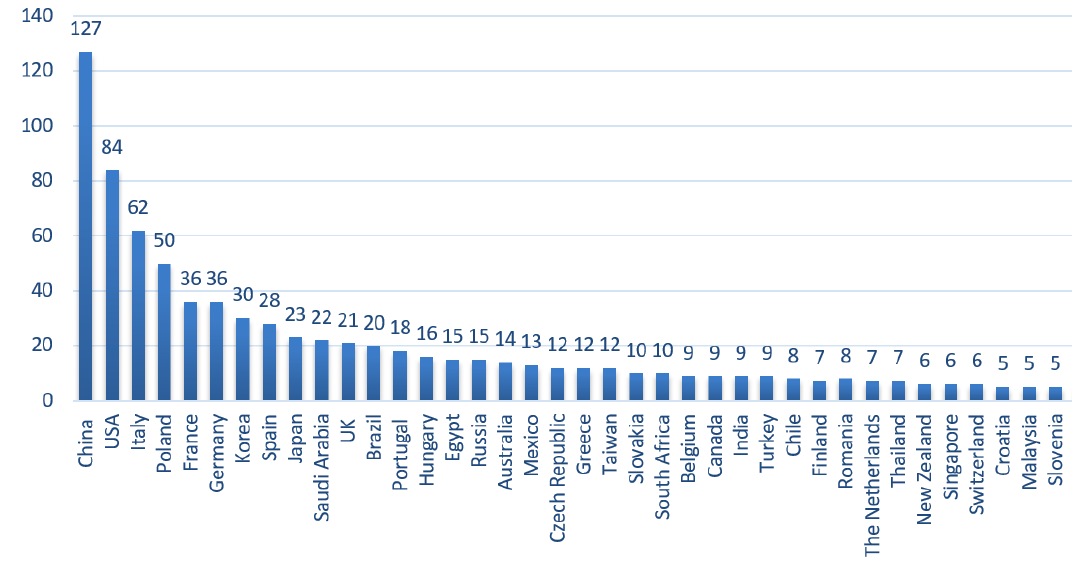
Figure 2. Geographical distribution of the corresponding authors of the papers published in the Medicinal Chemistry section of Molecules in 2019. The number of published articles is indicated on top of the bars. Only countries with five or more contributions are shown.